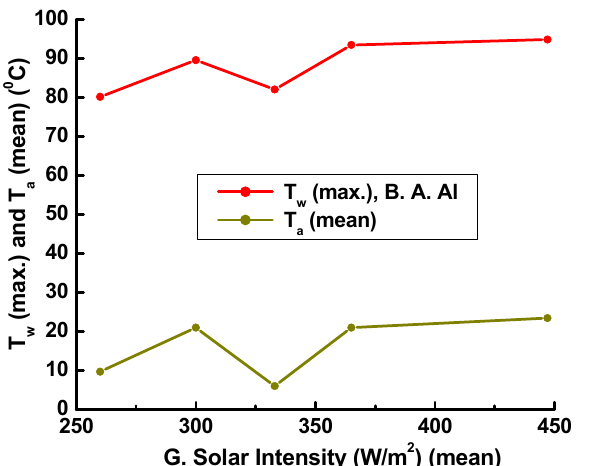
Figure 11. The maximum water temperatures and the mean values of ambient temperatures vs. the global solar intensity for different tests of solar heating.